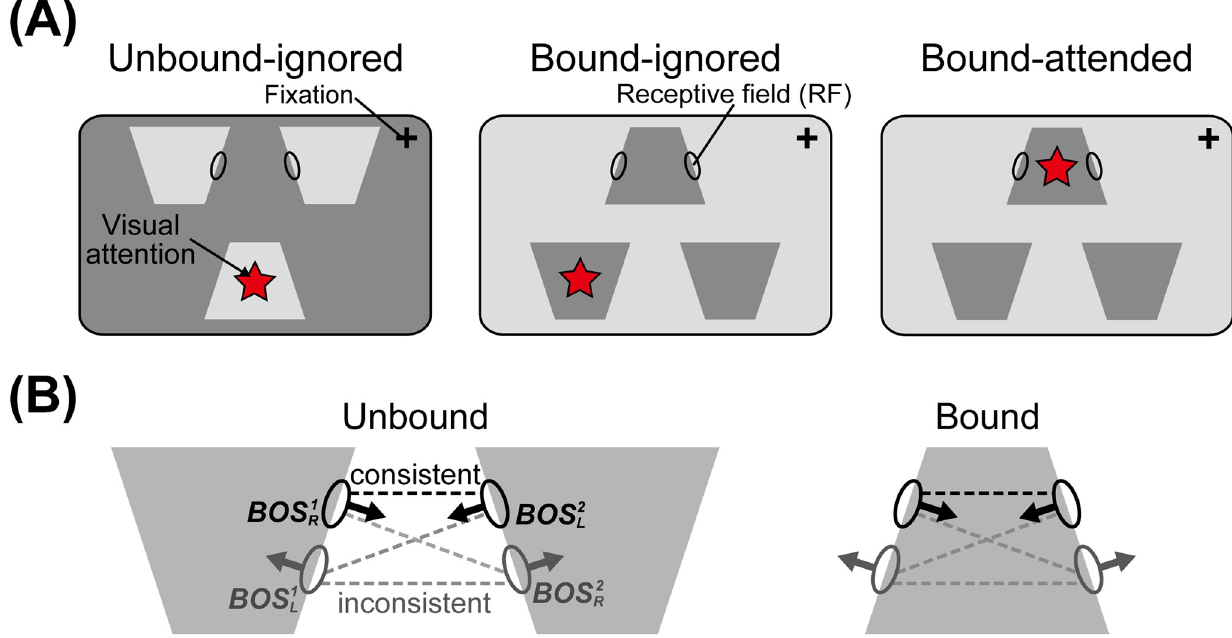
Fig 1. Pairs of BOS neurons and conditions for visual input and attention (modified from ref [39]). A: Stimulus displays for testing the effects of object integration and selective attention. Ellipses on the borders of the keystone-like objects represent the receptive fields (RFs) of border ownership selective (BOS) neurons. In each display, three separate objects are presented. In the left display the RFs of two neurons are on the borders of two different objects (“unbound” condition). In the middle and right displays the two RFs lie on the borders of the same object (“bound” condition). Note that the visual stimuli in and around the RFs are identical in all three conditions, but represent parts of two separate objects in the left display and parts of the same object in the other two displays. In these experiments, the monkey attended one of the objects, as shown by a red star (not part of the display). Such an object is called “attended” while objects that are not attended are referred to as “ignored.” B: Consistent and inconsistent pairs. Arrows from an RF point toward the preferred side of the corresponding BOS neuron. Subscripts L and R indicate left and right side-of-figure preferences, respectively, while retinotopic position is represented by the superscripts “1” and “2”. RFs of neurons whose border ownership preferences are consistent with representing a common object are connected by black dashed lines (“consistent pairs”), while RFs of neurons with inconsistent preferences are connected by gray dashed lines (“inconsistent